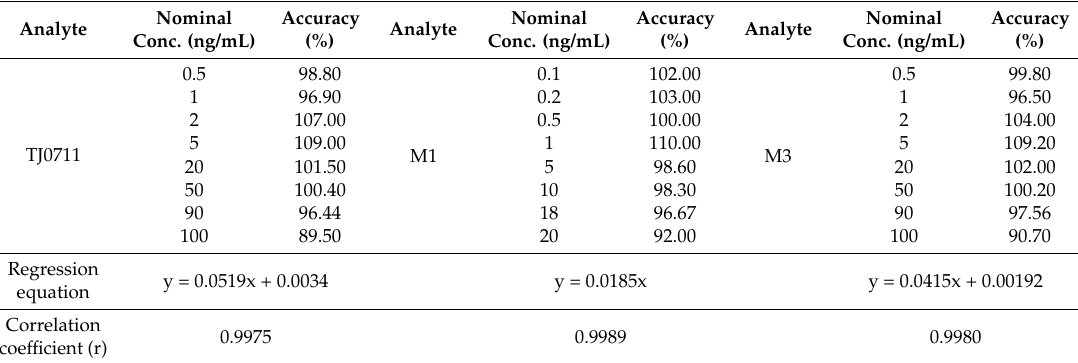
Table 1. Linear range, accuracy, regression equations, and correlation coefficients.